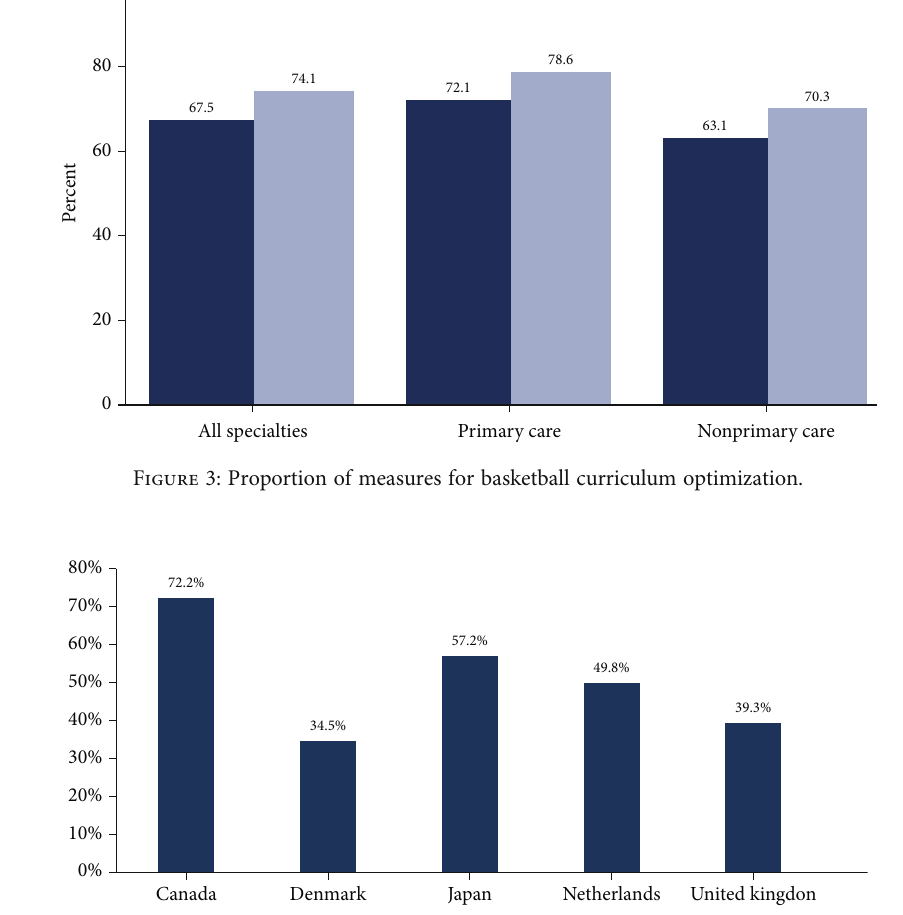
Figure 4: Importance of basketball special teaching in di ff erent countries.